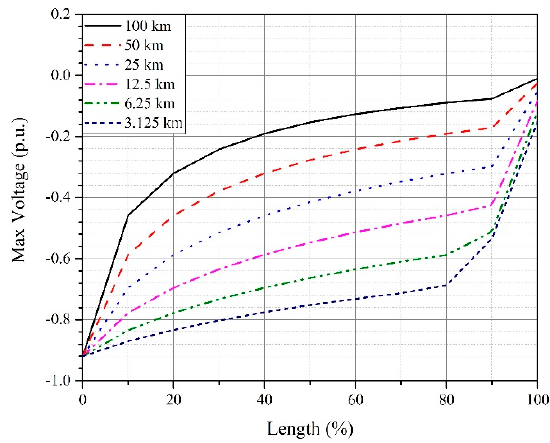
Figure 18. Maximum sheath-ground voltage along the length in cables with different lengths.